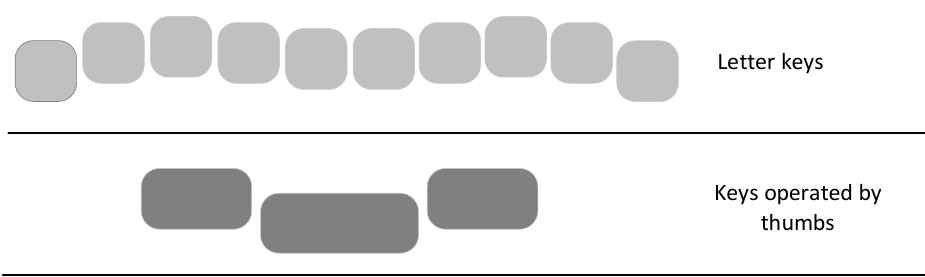
Figure 1. Example of One Row Keyboard (ORK) keyboard layout.